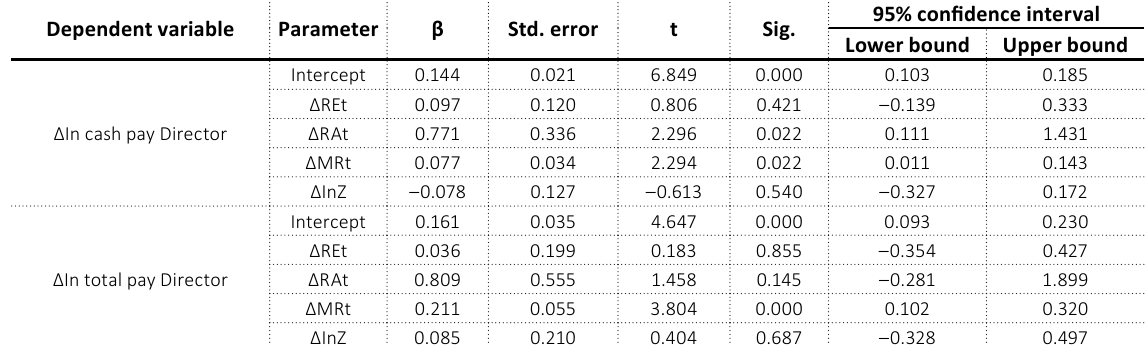
Table 3. R esults of the multivariate analysis for Director pay Parameter estimates – Director pay and company